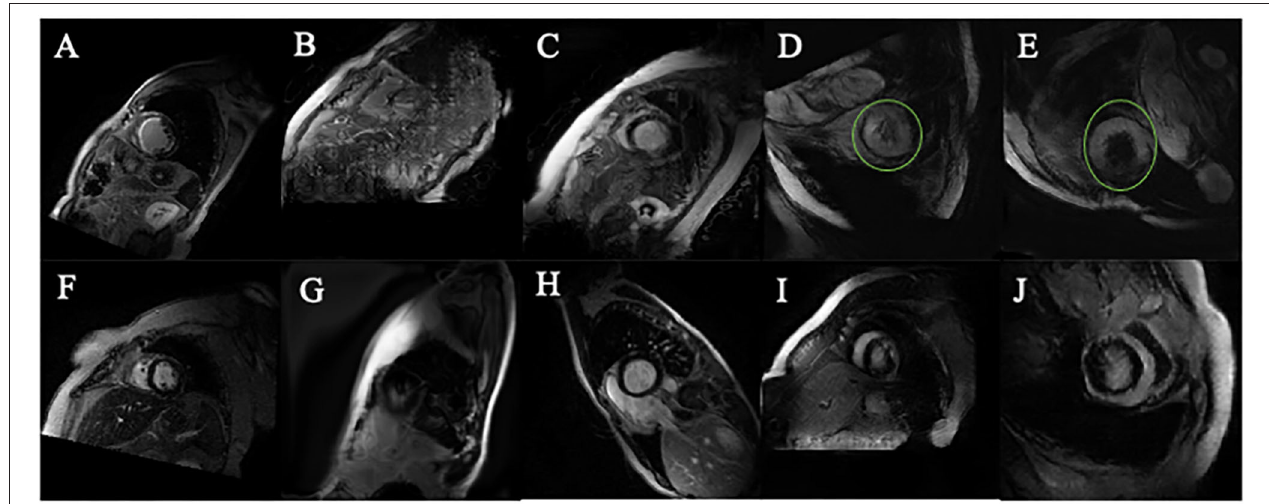
FIGURE 5 | Images generated by PGGAN and CycleGAN. (A) MI image from original data. (B) MI image generated form PGGAN. (C) MI image shifted by kmeans after PGGAN generation. (D) MI image generated from CycleGAN. (E) MI image shifted by kmeans after CycleGAN generation. (F) Control image from original data. (G) Control image generated form PGGAN. (H) Control image image shifted by kmeans after PGGAN generation. (I) Control image generated from CycleGAN. (J) Control image shifted by kmeans after CycleGAN generation. Green circle in (D,E) is manually added so as to mark the abnormal morphology of the generated image.